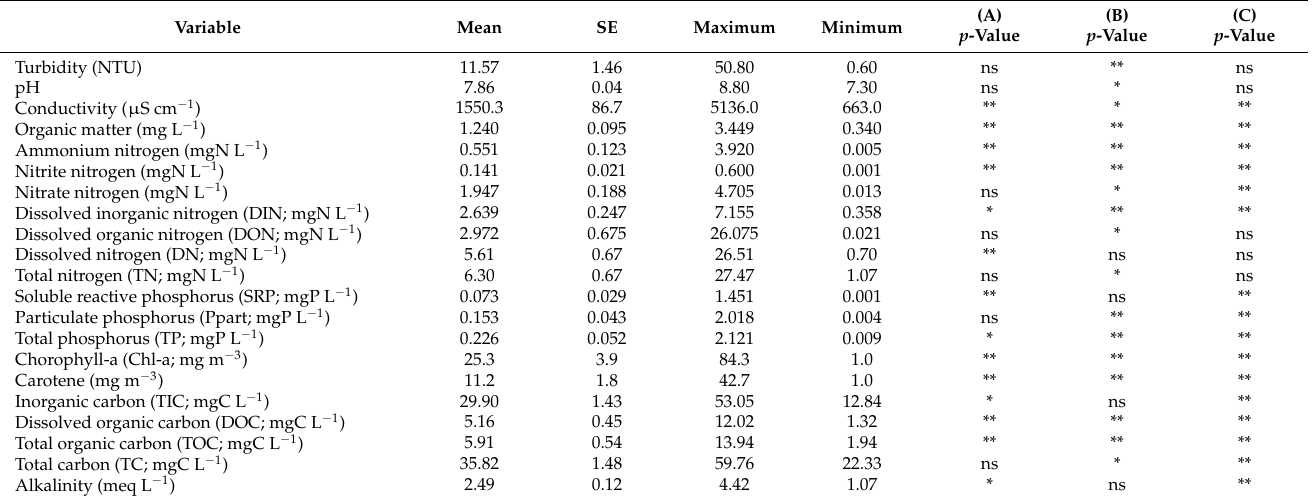
Figure 3. Statistically significant differences observed in the aquatic systems when comparing the beginning and ending of the rice cultivation period according to Student´s t -test results ( p < 0.05). Table 1. Mean, standard error, maximum and minimum values of the physico-chemical and biological variables studied in the water bodies during rice cultivation (May to October 2019), together with the results obtained for the Kruskal–Wallis tests to observe differences between (A) aquatic habitats, (B) agricultural activities and (C) irrigation zones. Probabilities are: * p < 0.05, ** p < 0.01; ns = not significant